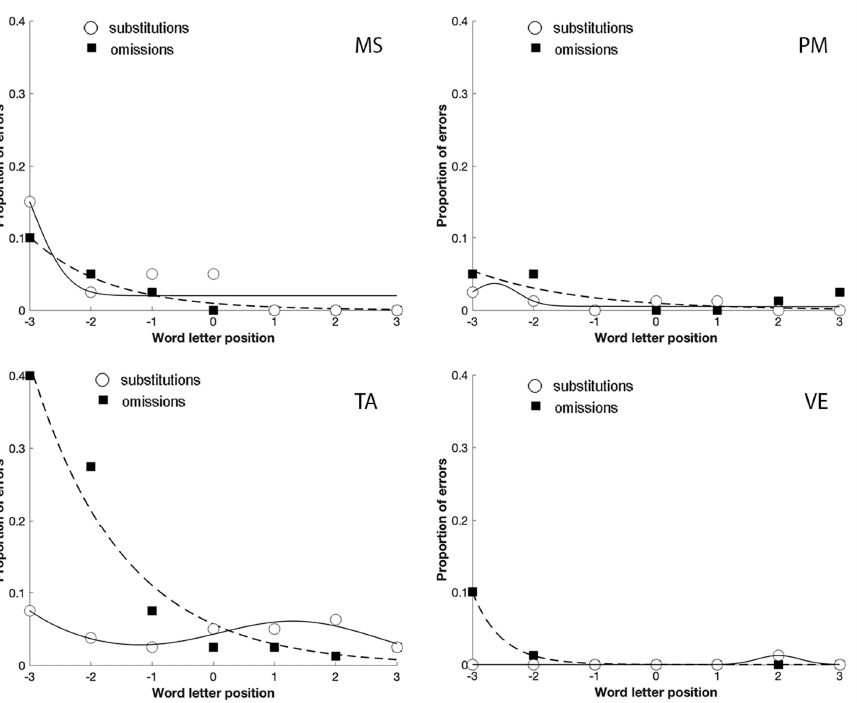
Figure 5. The distribution of omission and substitution errors made by the four patients with a prevalence of substitution errors in Experiment 2 in the spaced condition. 0 corresponds to the central letter in the string, positive values to the letters on the right and negative values to the letters on the left.